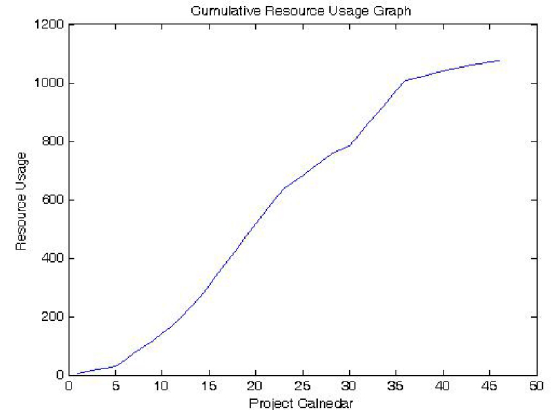
Figure 26. Cumulative resource usage for resource 1 of experiment 2 (after using forward